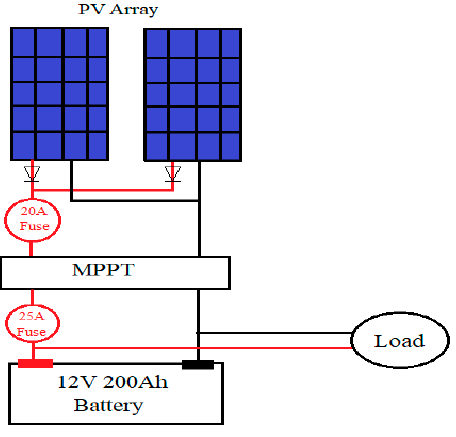
Figure 5. Overall photovoltaic (PV) system.